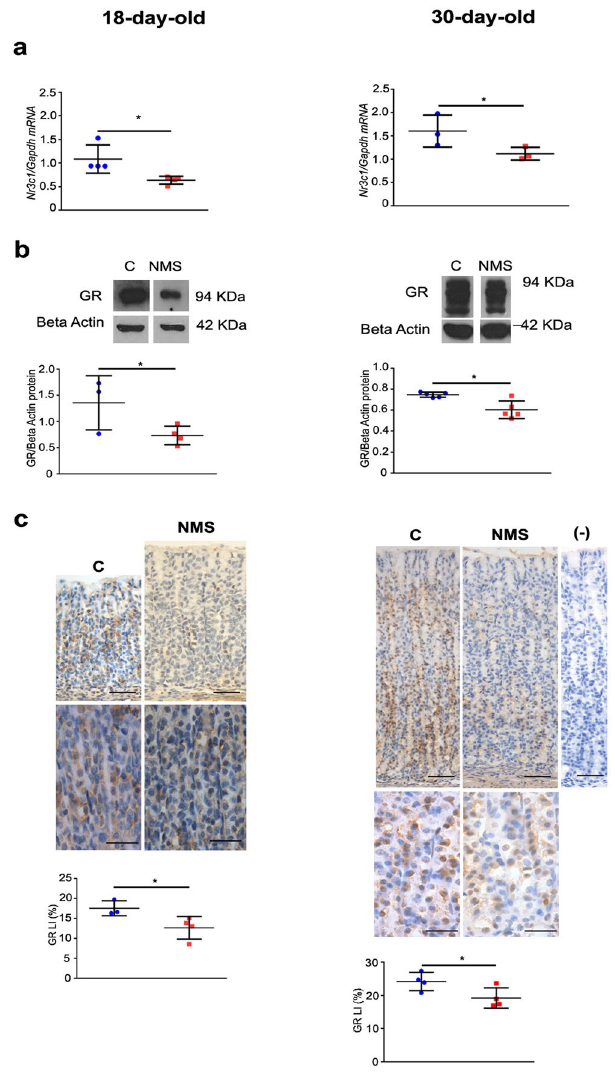
Figure 2. NMS effects on GR at gene expression (Nr3c1), protein levels and distribution in the gastric mucosa at 18 and 30 days. ( a ) Gene expression was evaluated by RT- qPCR and shown as fold change of Gapdh . ( b ) GR bands were cropped after immunoblot (Supplementary Fig. 4) to represent control and NMS groups. Protein levels were determined after comparison to the loading control with Beta- actin. ( c ) Representative photomicrographs of GR immunohistochemistry used to analyze receptor distribution. Labeling index (LI) (%) was obtained after cell counting. Negative control is devoid of any immunostaining. Bars = 50 µ m; high magnification at 30 days: bars = 25 µ m. Values are individually represented as well as means ± SD for control (blue) and NMS (red) groups. * P < 0.05 as compared to control group by Student t